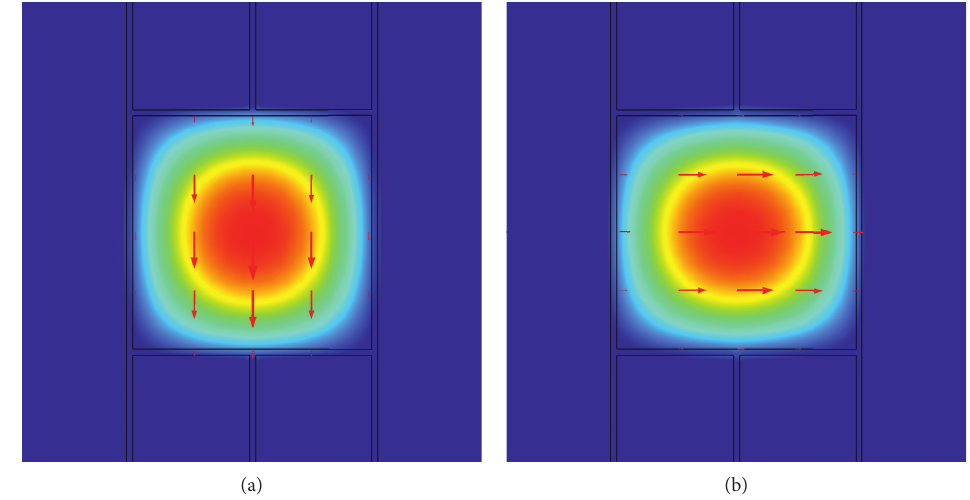
Figure 2: Wave propagation profile for the proposed R-PCF-based BCS. (a) x -PoM and (b) y -PoM.